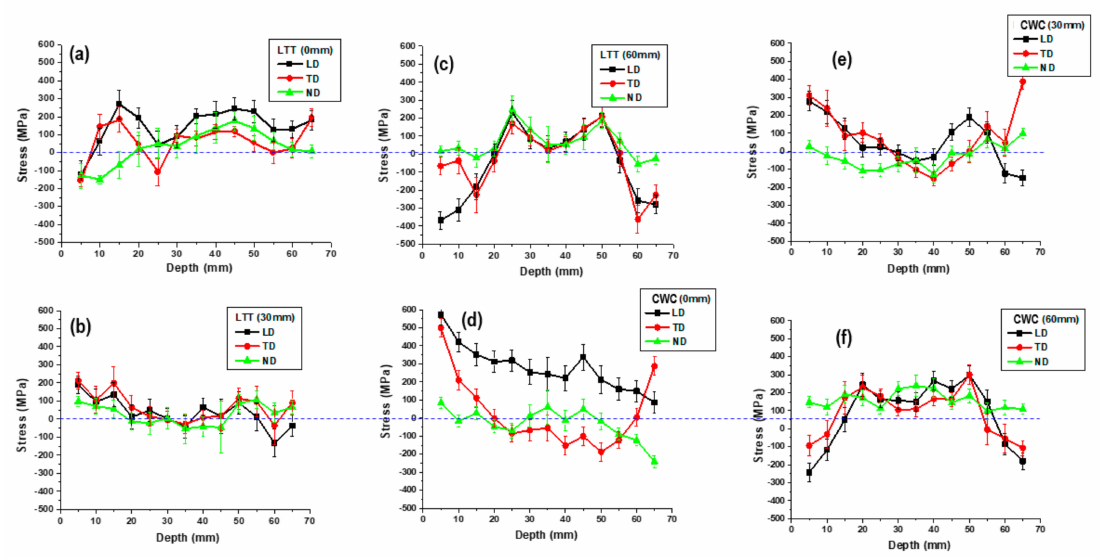
Figure 12. Residual stress distribution of low transition temperature welding consumable and commercial welding consumable. ( a ) LTT, 0 mm; ( b ) LTT, 30 mm; ( c ) LTT, 60 mm; ( d ) CWC, 0 mm, ( e ) CWC, 30 mm; ( f ) CWC, 60